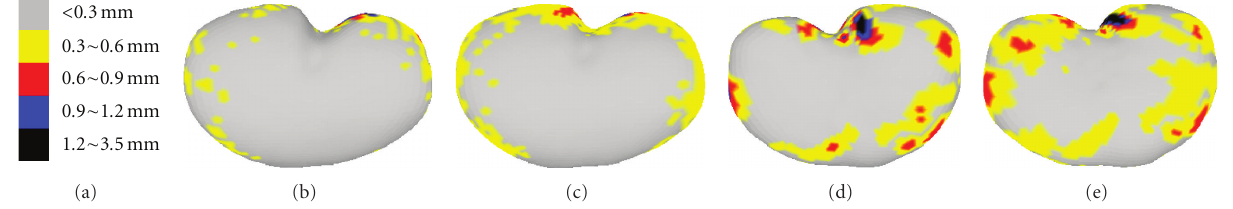
Figure 21: Representation error in intermodel Ex3: (a) color-coded scales, (b) example of color-coded point error in training set, (c) 90% color-coded point error in training set, (d) example of color-coded point error in testing set, and (e) 90% color-coded point error of testing set.